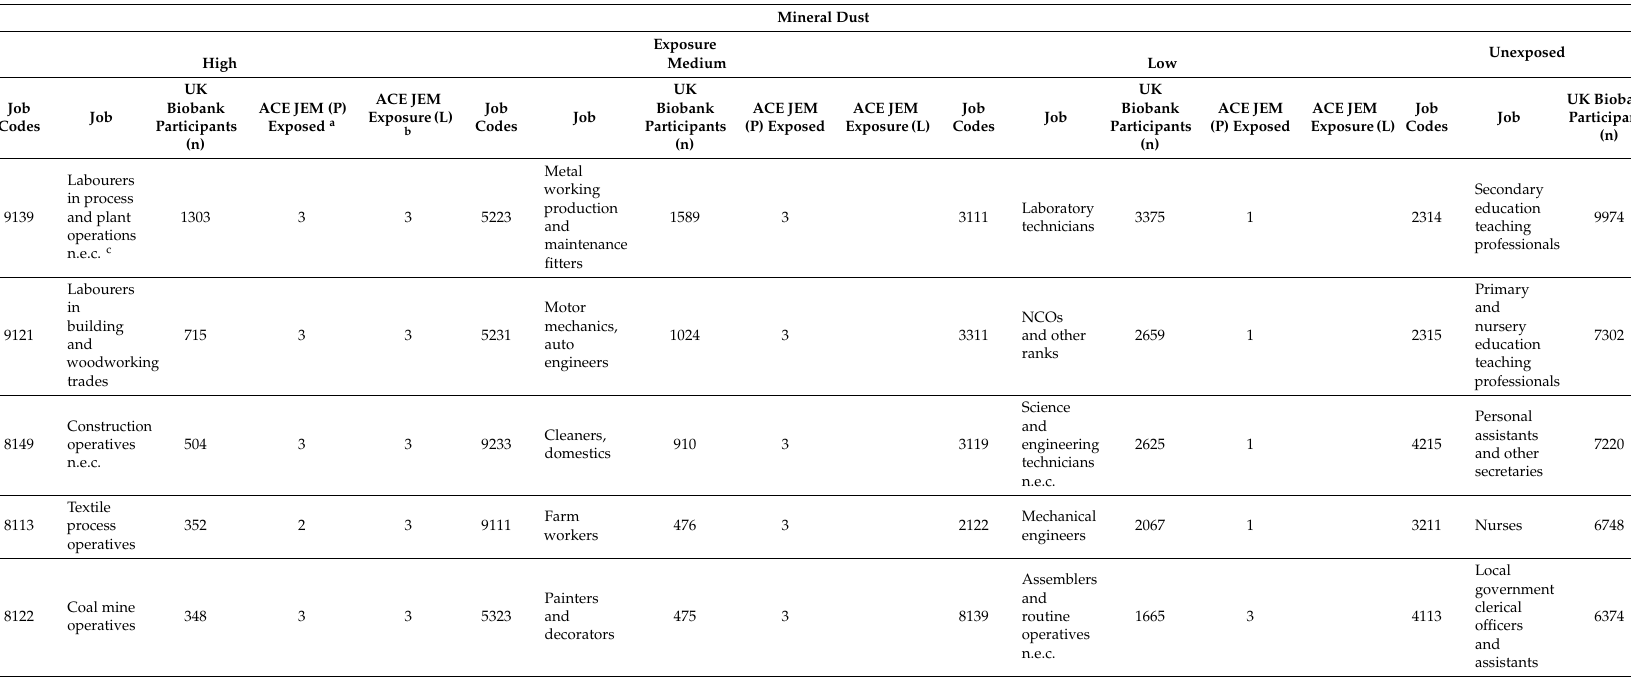
Painters and decorators